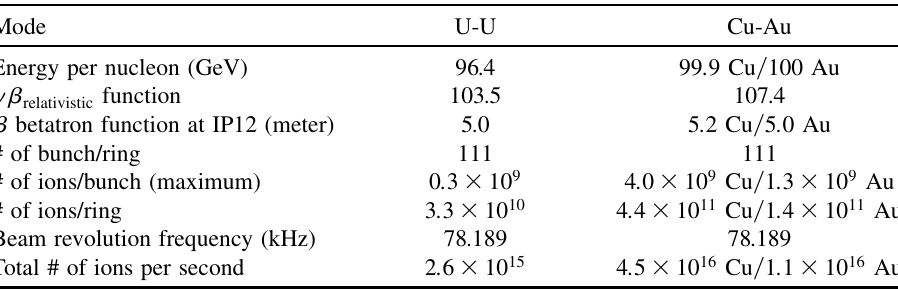
TABLE I. RHIC run-12 machine parameters.